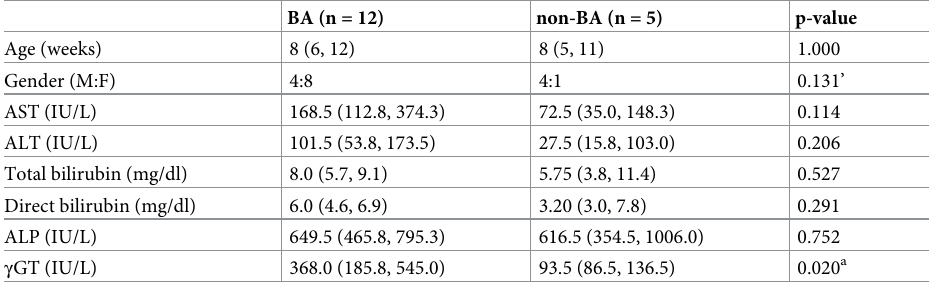
Table 1. Comparison of clinical and laboratory results between BA and non-BA groups. BA (n =